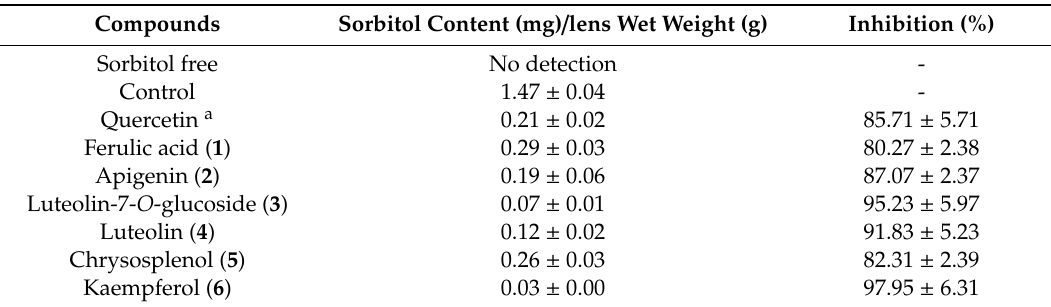
Table 4. Inhibitory e ff ects of rat lens aldose reductase-active compounds Tanacetum parthenium L. on sorbitol accumulation in the rat